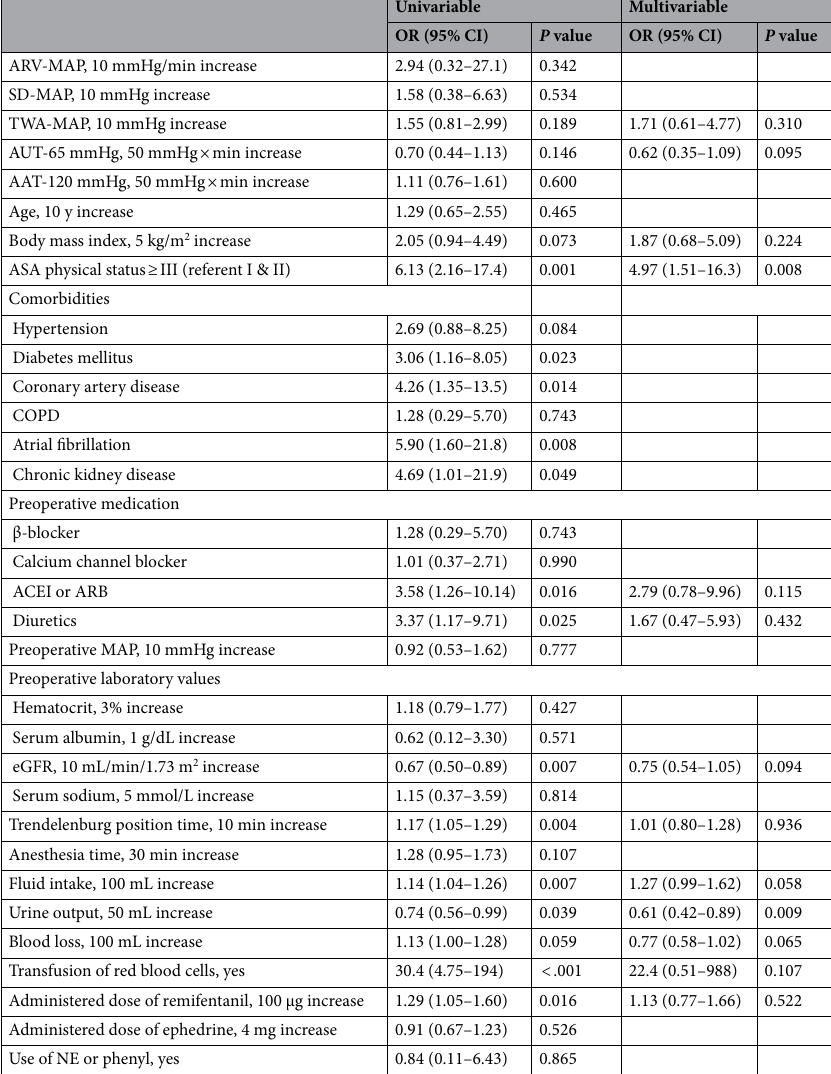
Table 4. Univariable and multivariable analyses of risk factors for postoperative acute kidney injury. OR odds ratio, CI confidence interval, ARV average real variability, SD standard deviation, TWA time-weighted average, MAP mean arterial pressure, AUT area under threshold, AAT area above threshold, ASA American Society of Anesthesiologists, COPD chronic obstructive pulmonary diseas, ACEI angiotensin-converting enzyme inhibitor, ARB angiotensin receptor blocker, eGFR estimated glomerular filtration rate, NE norepinephrine, Phenyl phenylephrine.